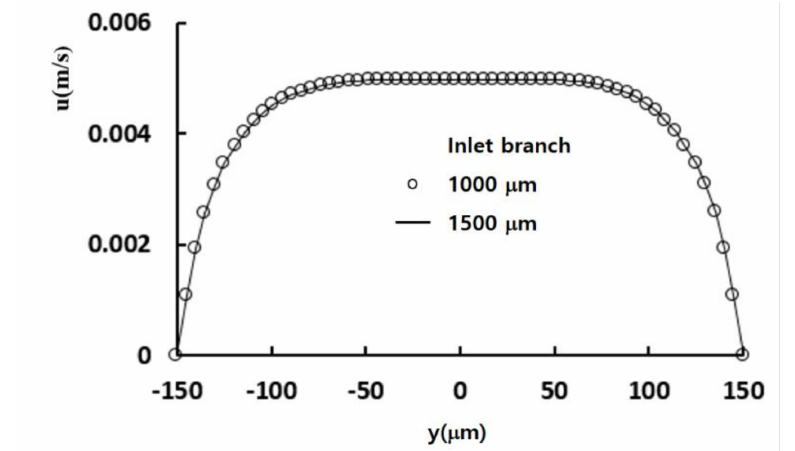
Figure 9. Comparison of velocity component at the